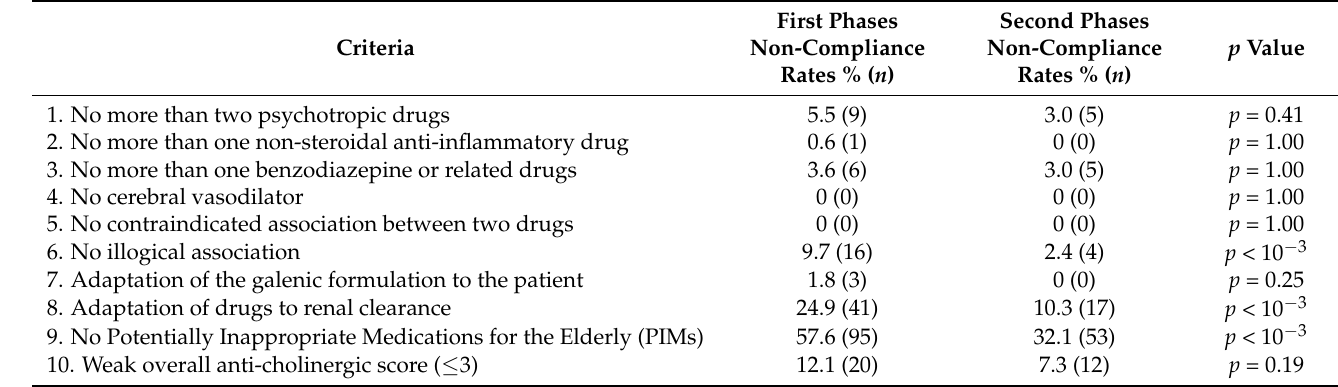
Table 4. Criteria non-compliance rate comparison between the two